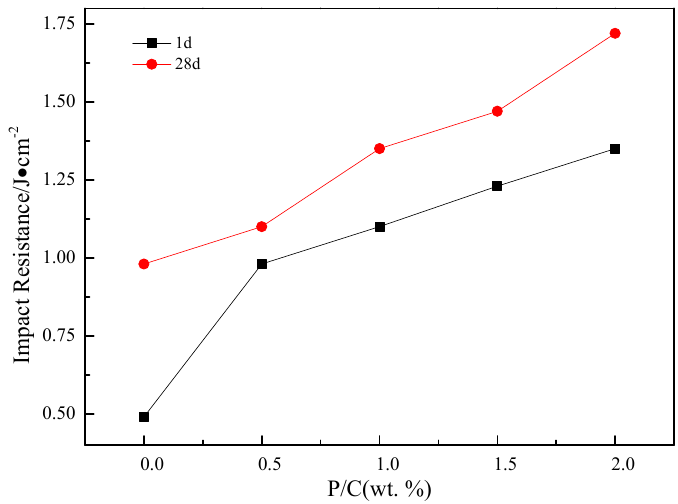
Figure 5. The impact resistance of mortar.